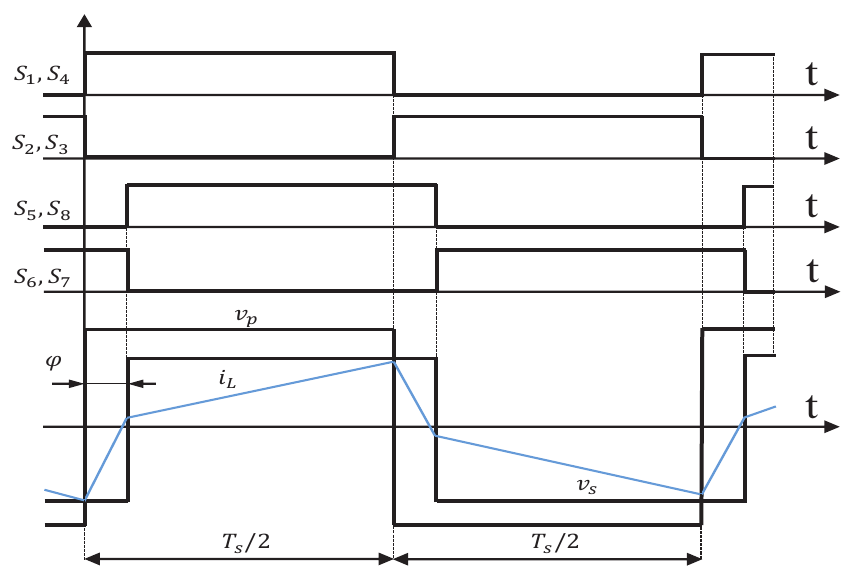
Figure 2. Operating waveforms of the DAB converter using SPS modulation. To be specific, a pair of switches S 1/ S 2, S 3/ S 4, S 5/ S 6, and S 7/ S 8 operates comple- mentarily, as shown in Figure